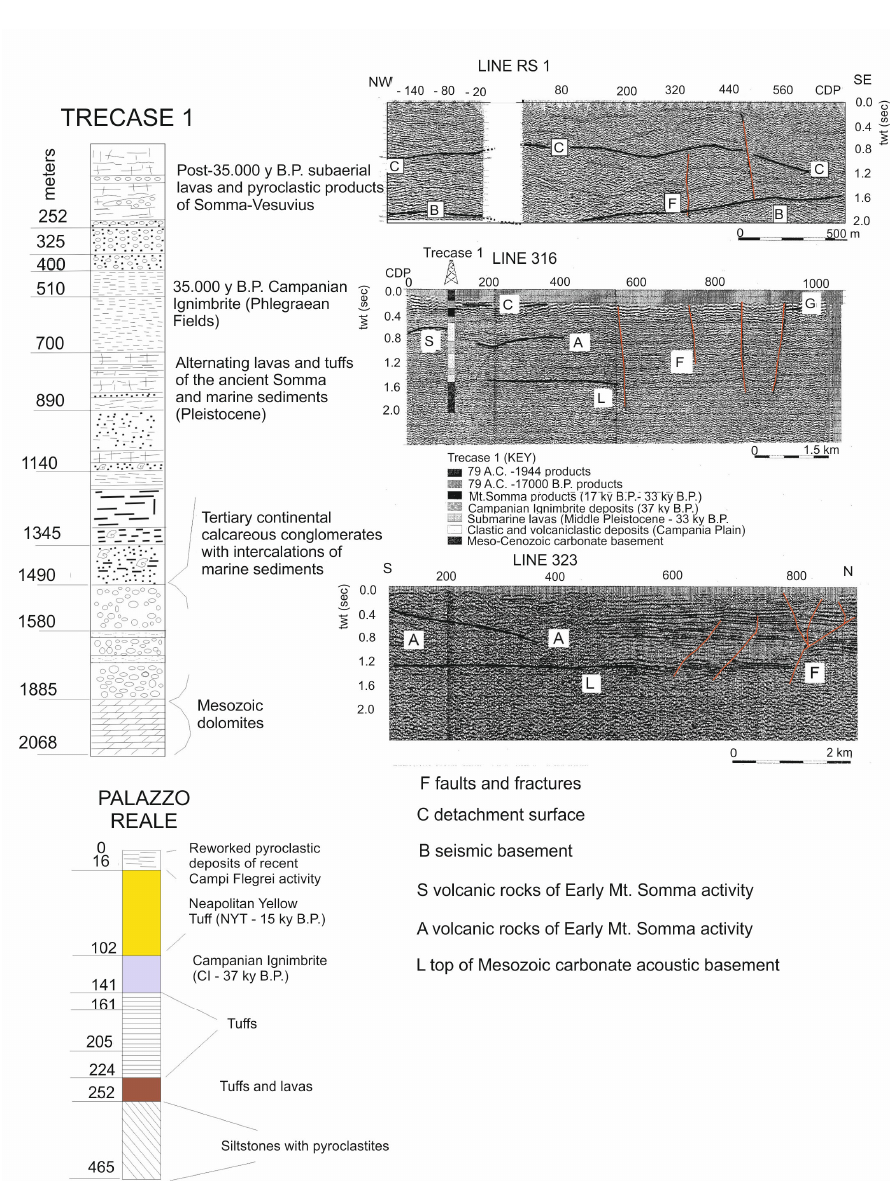
Figure 2. Sketch stratigraphy of the exploration well “Trecase 1” (modified after [36]), integrated with the seismic profiles recorded onshore in the Vesuvius area and calibrated by the Trecase 1 well (modified after [2]). The stratigraphy of the “Palazzo Reale” borehole (modified after [37]) has also been reported.